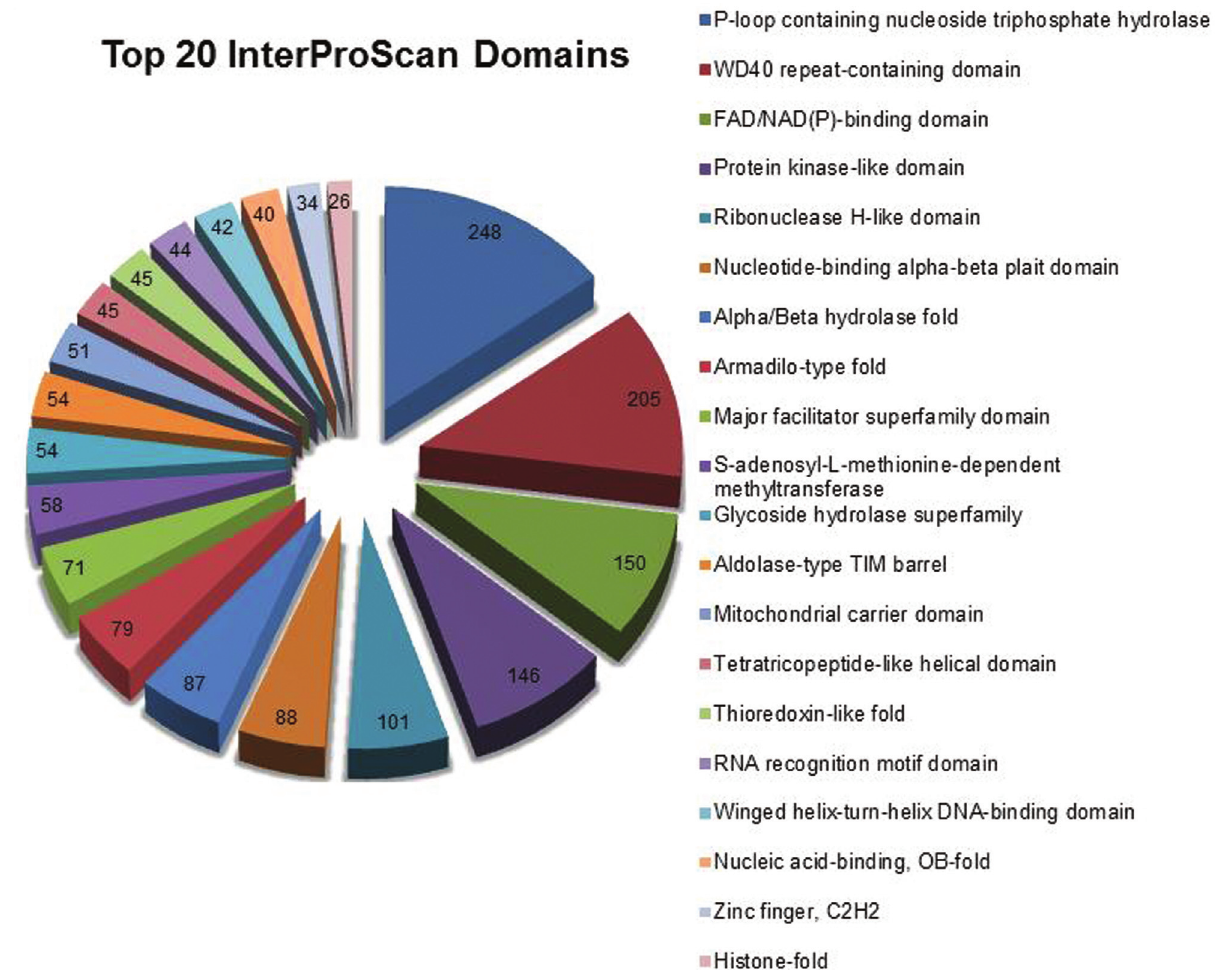
Figure 1 - The most represented InterProScan domains associated with P. pachyrhizi transcripts. The number of sequences found for each domain is